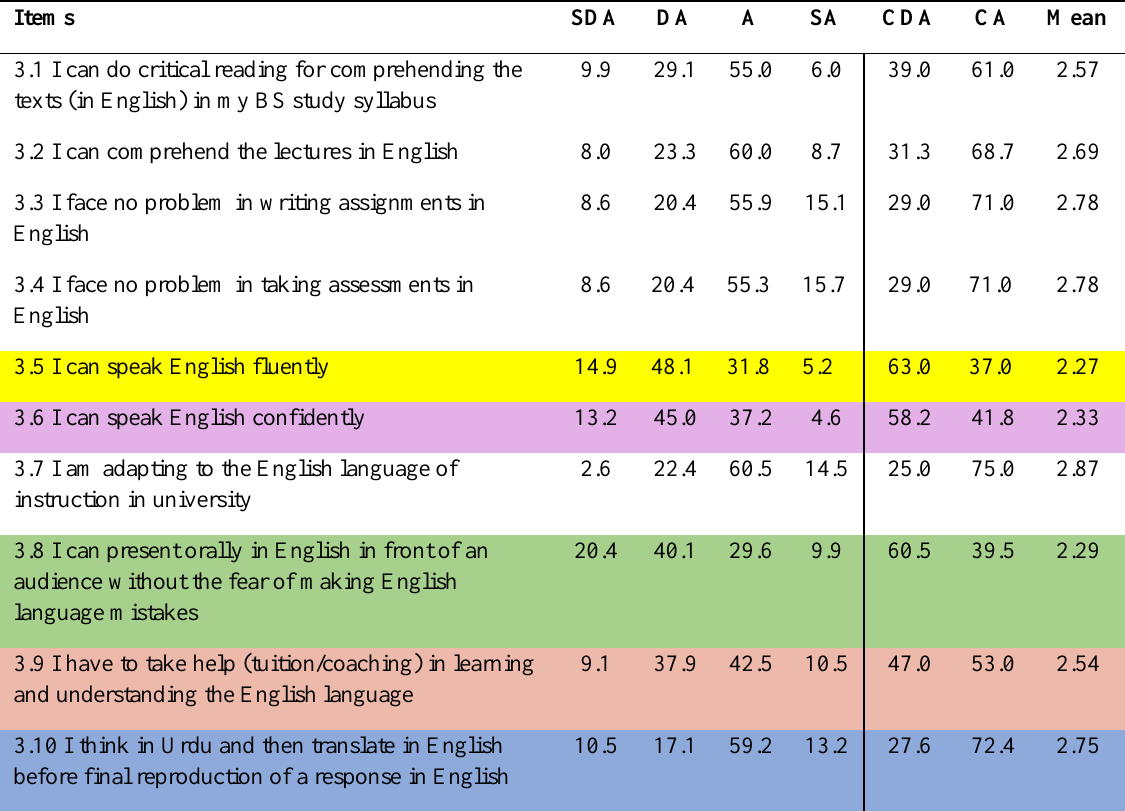
Linguistic Adaptation